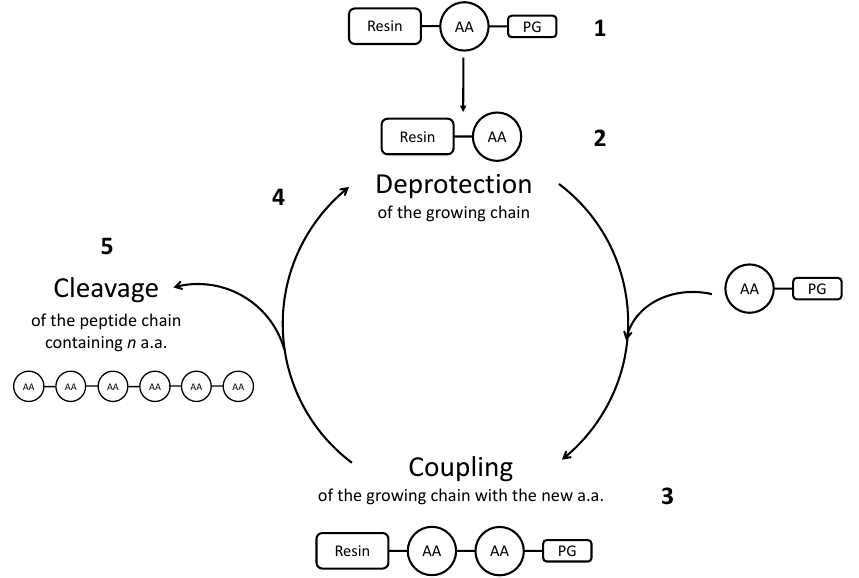
Figure 1. Scheme representing Solid Phase Peptide Synthesis. (1) An amino acid (AA) is protected on the functional group that must not react, and it is bonded to an insoluble resin. Then, its protecting group (=PG) is removed (2), so that the following amino acid, which in turn is protected, can bond to the growing chain (3). Successively, also the second amino acid is deprotected, to add the third one (4). After all the amino acids have been added, the peptide chain is recovered from the synthesis mixture with the step called cleavage